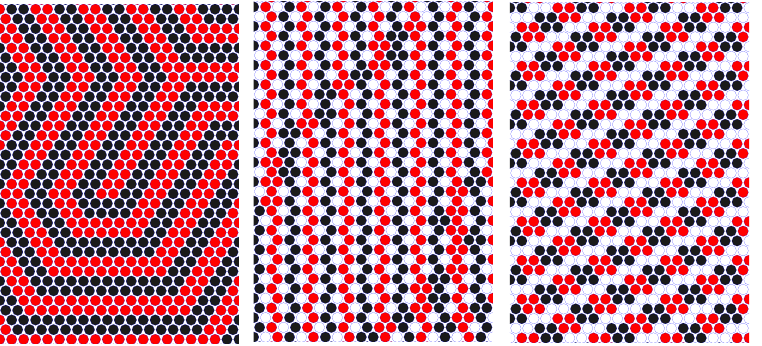
= µ ∗ . ( Left , central, 2 1 = µ ∗ = 0.0, µ ∗ = µ ∗ = − 3.2, and µ ∗ = µ ∗ = − 3.8, respectively. 2 2 2 1 1 1